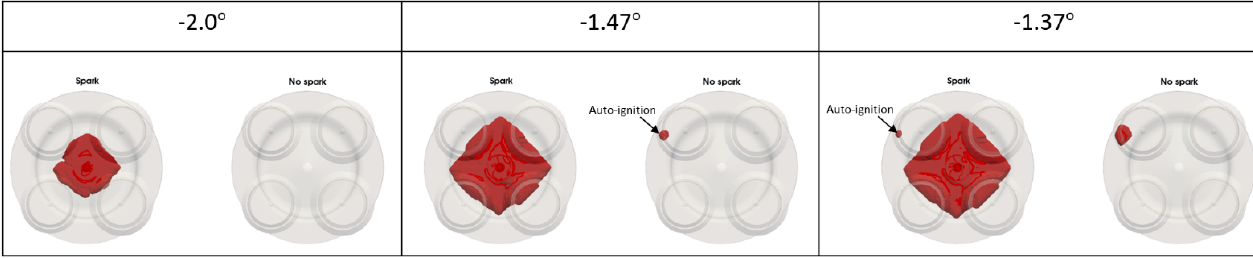
Figure 6. Comparison of temperature iso-surface (1600–3000 K) for spark vs. no-spark cases.